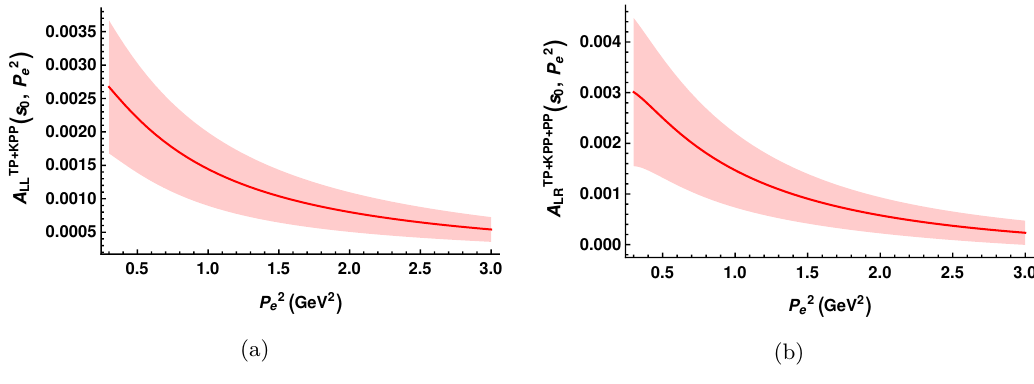
( s ) (left pannel) and A TP + KPP + PP 2 0 , P e LL = (1 . 44 GeV ) 2 and M 2 = 2 GeV 2 along with the uncertainties 0